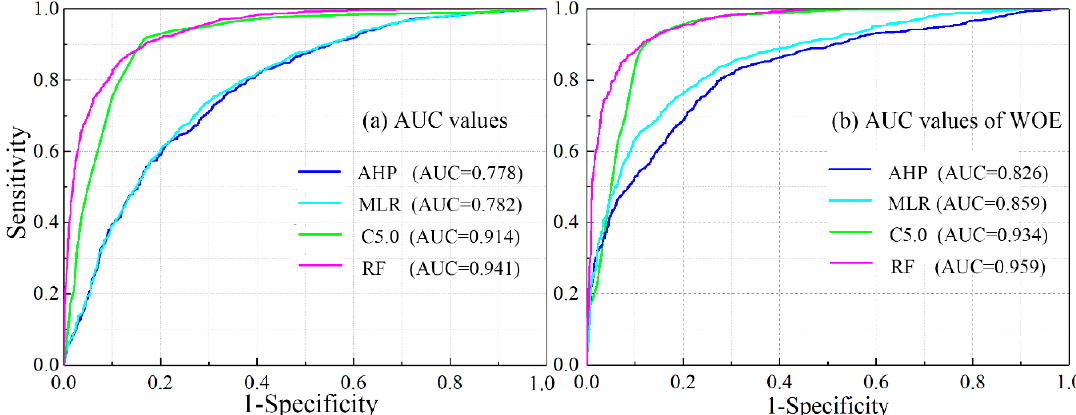
Figure 13. ROC curves of ( a ) data-based models and ( b ) WOE-based models.